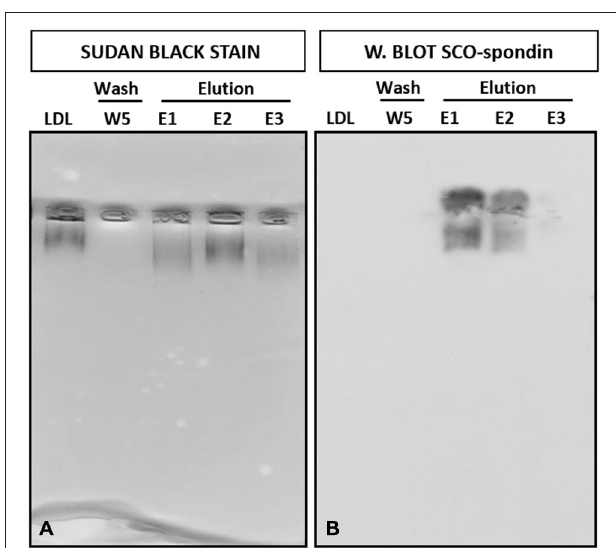
FIGURE 2 | Migration pattern of lipoproteins and SCO-spondin from the eCSF. (A) Detection of eCSF lipoproteins by staining with Sudan black and posterior native agarose gel electrophoresis, showing the presence of low density lipoproteins (LDL) and high density lipoproteins (HDL) (arrows) in the eCSF of HH30 chick embryo. Human LDL and HDL and fetal bovine serum (FBS) were used as positive controls. (B–D) Migration pattern of lipoproteins and SCO-spondin